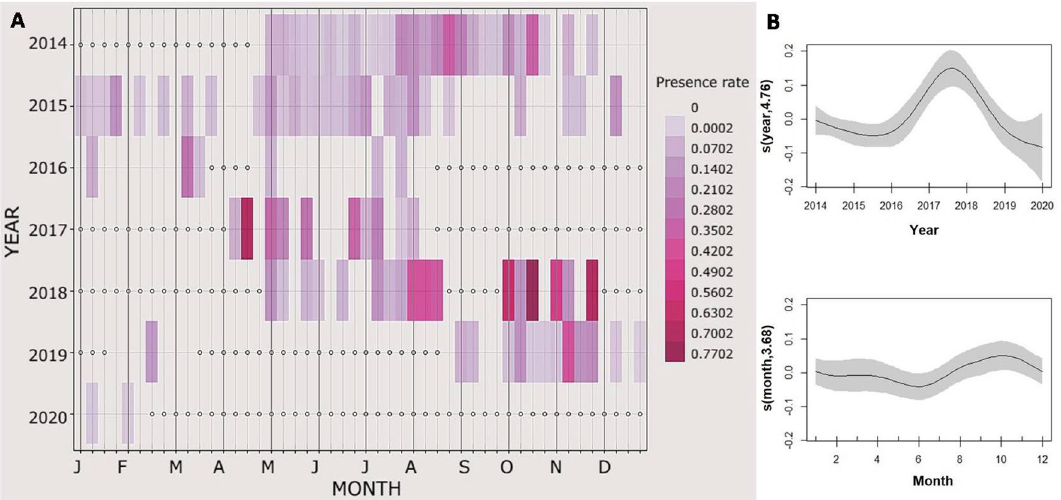
Figure 3. ( A ) Fin whale acoustic presence per week (presence rate) along the 7 years considered. White dots represent absence of data. ( B ) Response curves of the variables in the Generalized Additive Models (GAMs) performed testing PR as a function of the predictors Year and Month. The solid lines represent the smoothed estimates by the GAM, while the grey areas represent the approximate 95% confidence intervals.